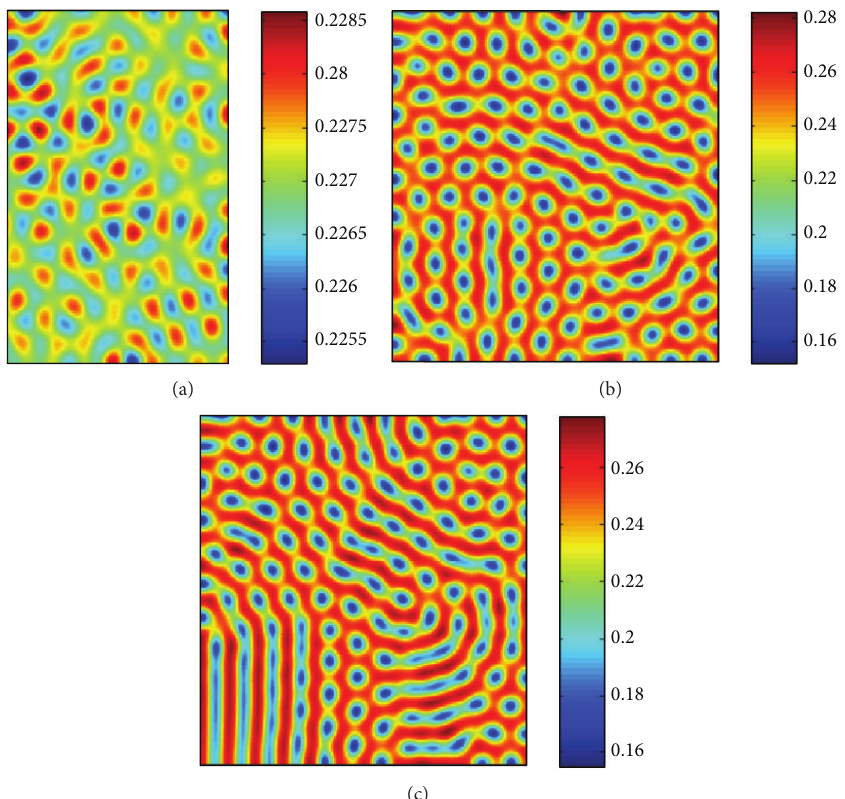
Figure 4: Snapshots of contour pictures of the time evolution of predator in system (3) when 𝑑 2 = 7 and 𝛿 𝐻 < 𝛿 = 0.535 < 𝛿 𝑇 : (a) 30000 iterations, (b) 100000 iterations, and (c) 200000